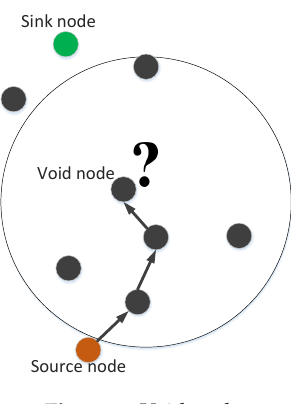
Figure 2. Void node.